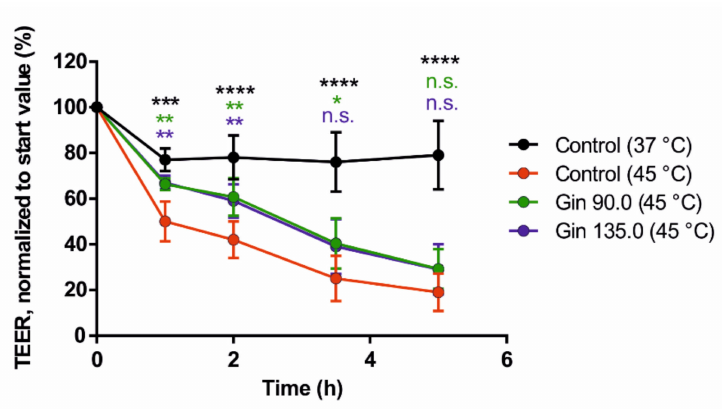
Figure 3. E ff ects of ginseng extract on the transepithelial electrical resistance (TEER) values of Caco-2 monolayers on transwell inserts, representing intestinal barrier integrity. Caco-2 cells were grown on collagen-coated 0.4- µ m transwell inserts and di ff erentiated into monolayers. The cells were incubated with ginseng extract at ginsenoside concentrations of 90 mg / L (Gin 90.0) and 135 mg / L (Gin 135.0) throughout the di ff erentiation period. The TEER values are normalized to the respective start value. Error bars are based on the standard deviation ( n = 6). **** p < 0.0001, *** p < 0.001, ** p < 0.01 and